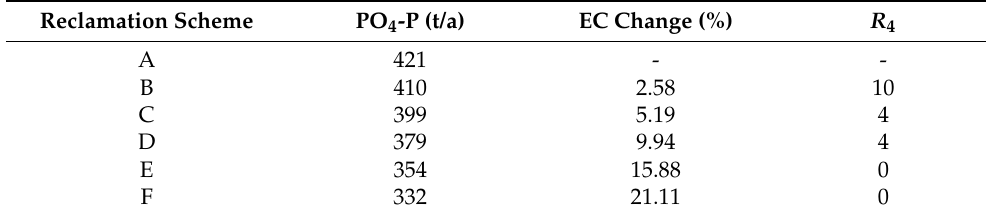
Table 22. Feasibility evaluation of PO 4 -P environmental capacity.